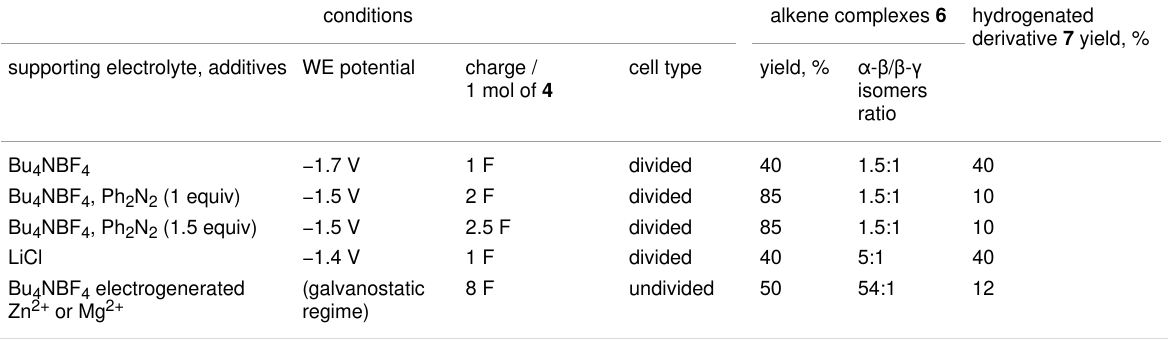
derivative 7 yield, %